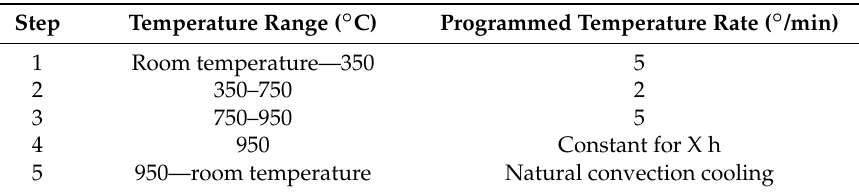
Table 1. Heating parameters for reduction